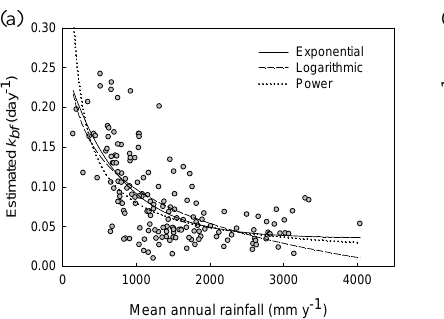
Fig. 5. Scatter plots of recession coefficient k bf versus (a) MAR, (b) TMI, (c) AI, (d) SI, (e) SLO and (f) TC. Symbols denote a proxy for aquifer drainage potential from WHYMAP (2010).